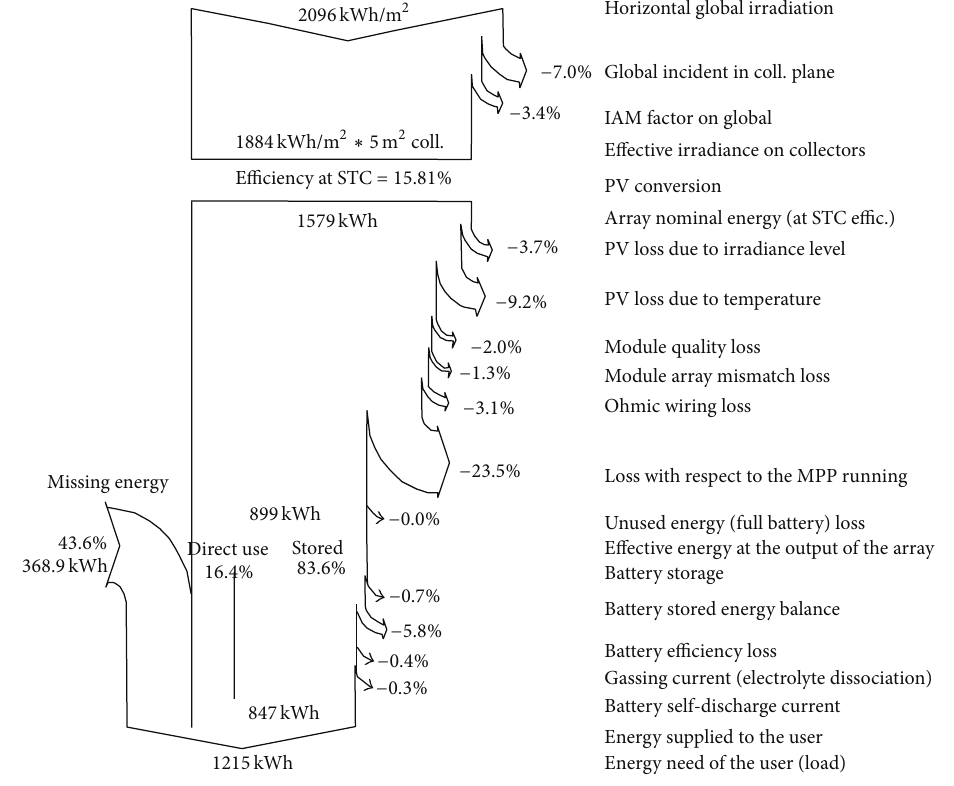
Figure 13: Energy losses diagram.